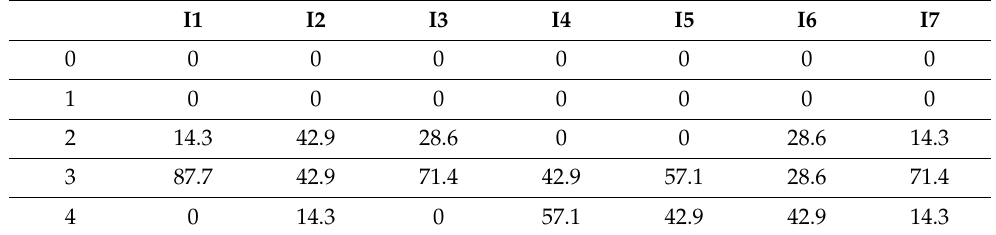
Table 4. Impact of building empathy on the team.